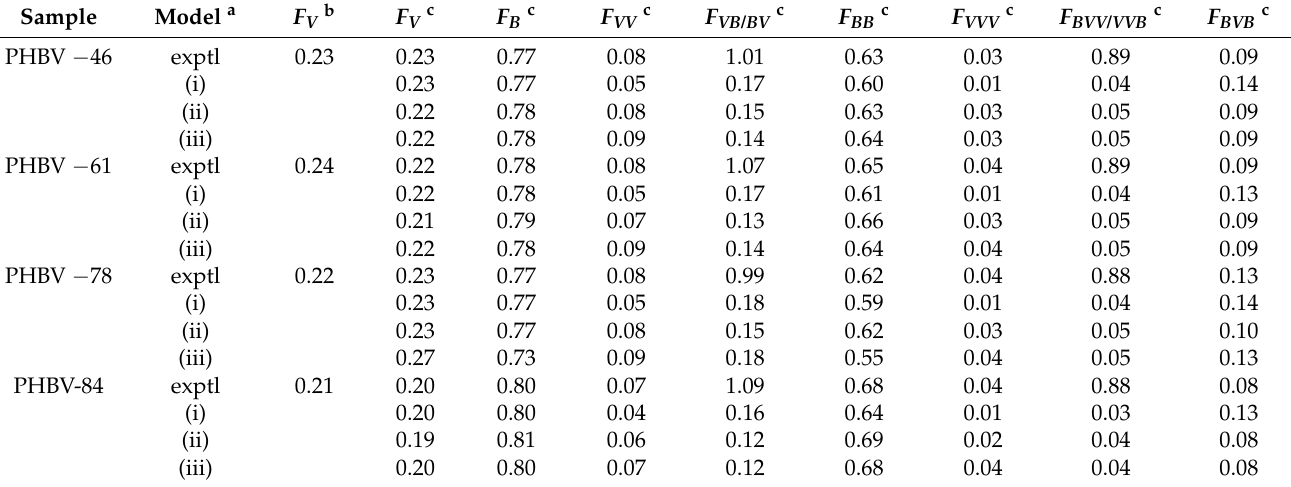
Table 7. Experimental and calculated mole fractions of diad, and 3HV-centered triad sequence distributions of PHBV − 46, − 61, − 78, and −